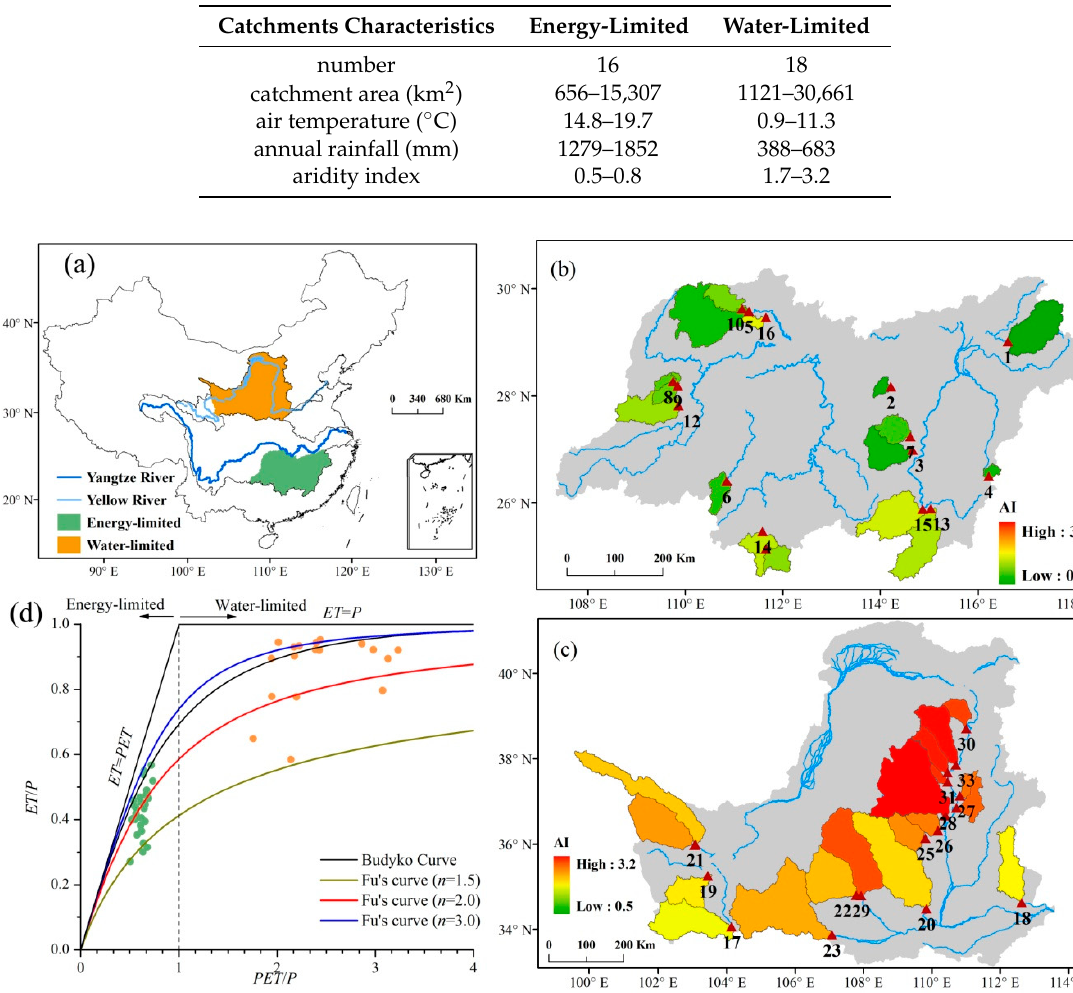
Table 1. Information of the studied catchments under different climatic conditions.